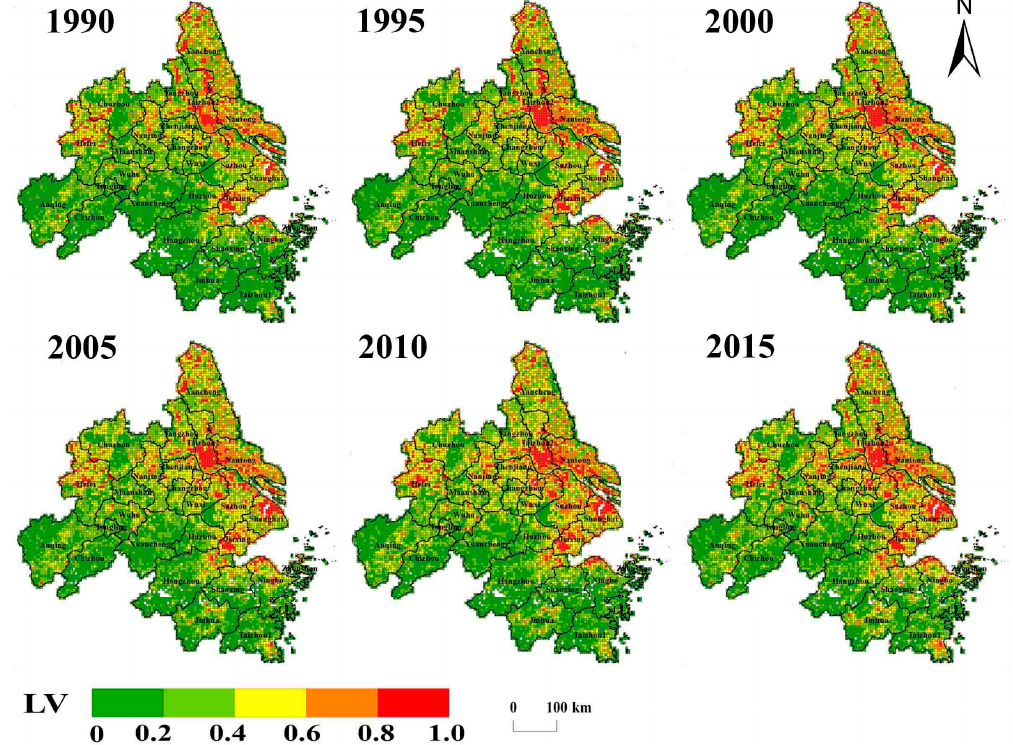
Figure 6. The spatial variation of LV at the 5 km-grid scale in the YRD from 1990 to 2015. The white grid cells indicate there was no common edge between the urban landscape and natural landscapes.